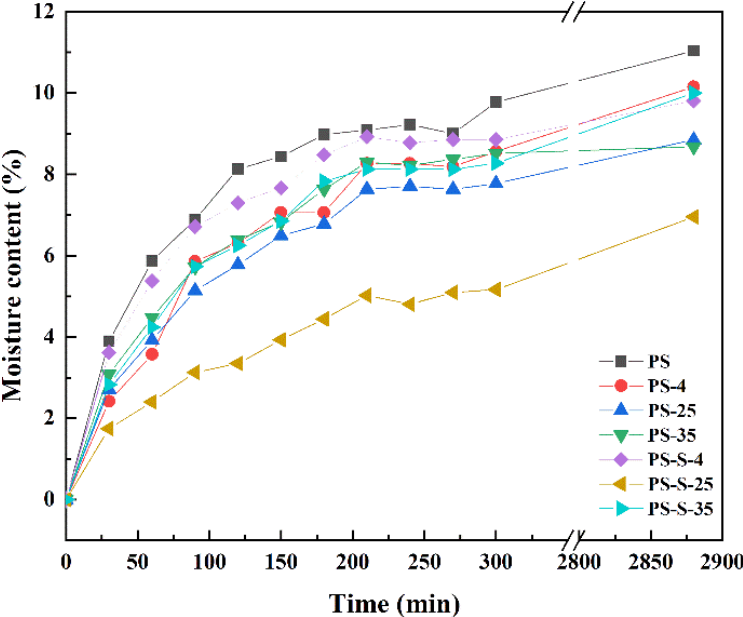
Figure 7. Moisture absorption of PS, PS-4, PS-25, PS-35, PS-S-4, PS-S-25, and PS-S-35 samples.